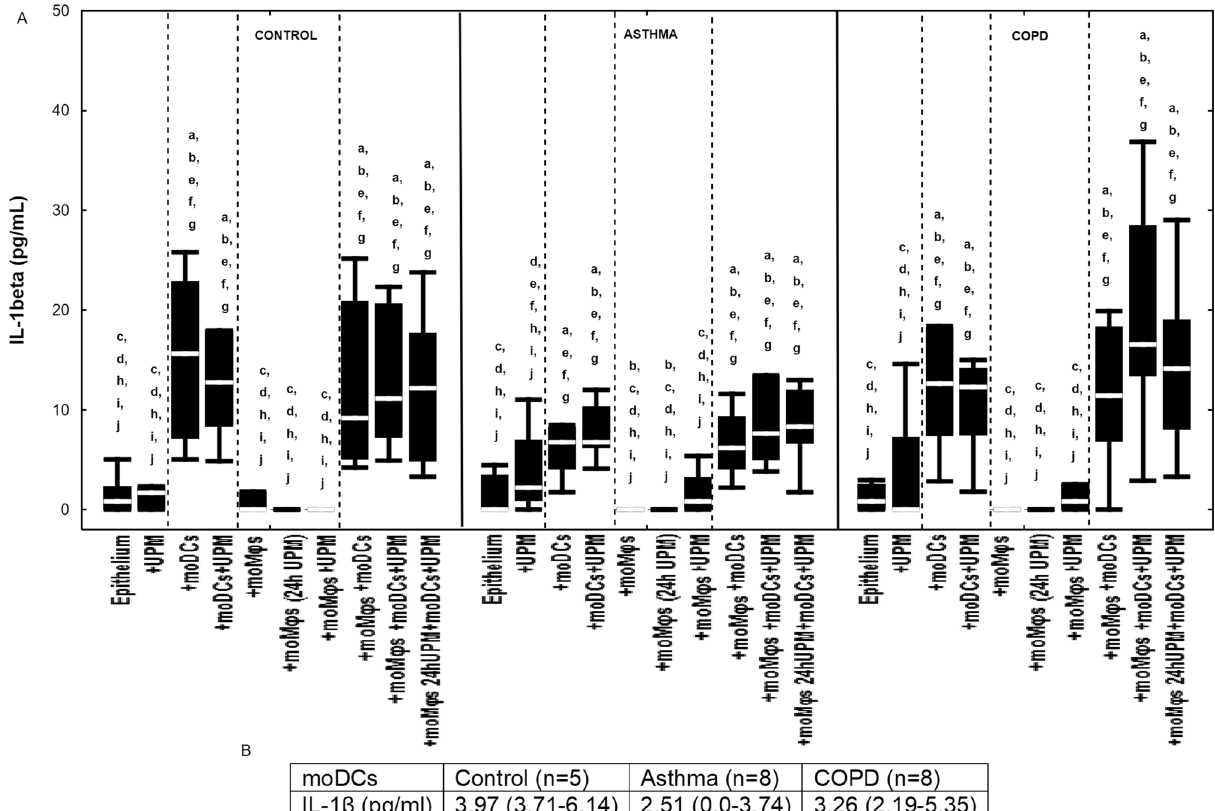
Figure 9. ( A ) IL-1β secretion by air–liquid interface (ALI) cultured nasal epithelium after 24 h UPM exposure in multi co-culture schemes in control subjects, asthma and COPD patients. ( B ) IL-1β levels produced by moDCs cultured alone are shown in table. The data are shown as non-outlier range (whiskers), interquartile range (box) and median (line). The exact p value calculated after Mann–Whitney U test are shown in supplementary file (Table S5, Table S6 and Table S7). The p value < 0.05 in comparison to: a—epithelium, b—epithelium + UPM, c—epithelium + moDCs, d—epithelium + moDCs + UPM, e—epithelium +